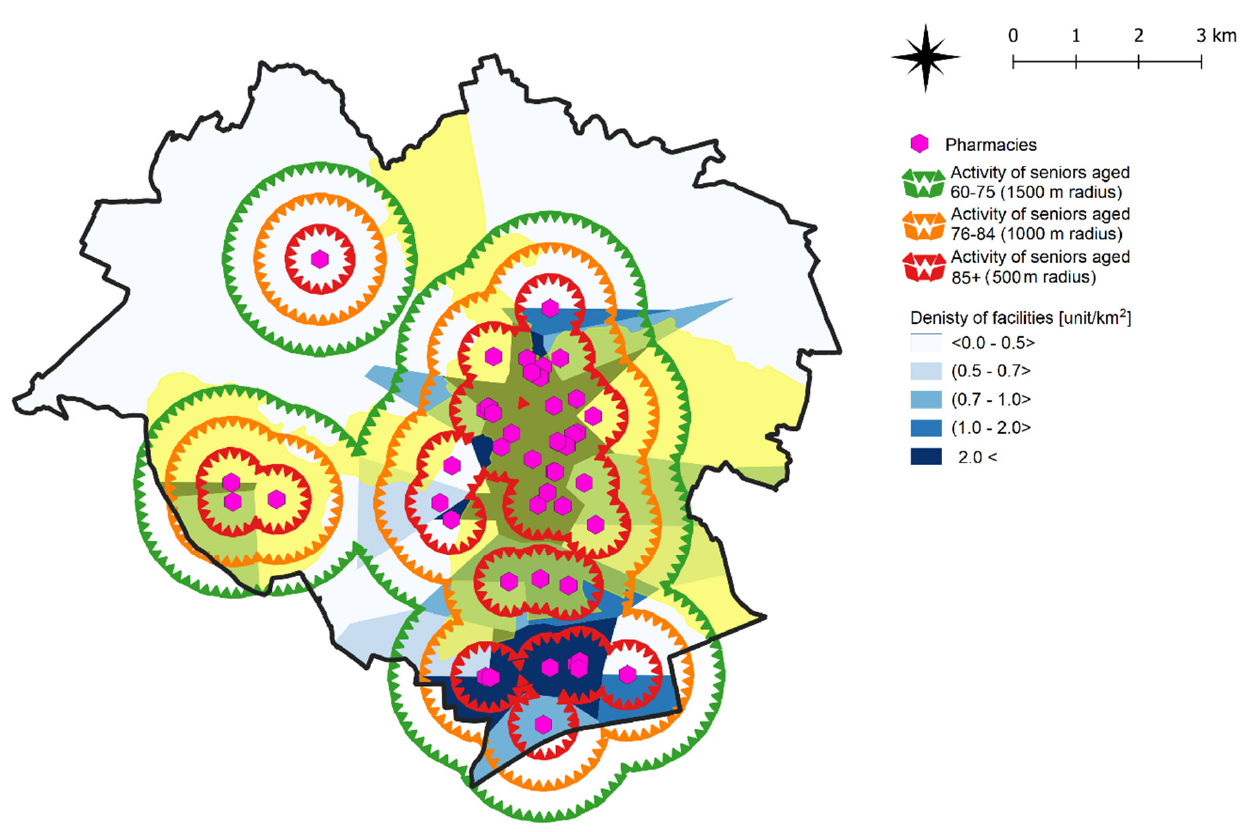
Figure 11. Apparent social dynamics of seniors’ activity on the example of pharmacies and the location of districts inhabited by the surveyed seniors in Olsztyn, for all age groups. Source: own elaboration.